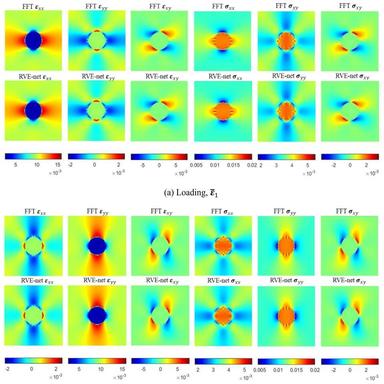
Errors of the strain predicted by RVE-net for the three loading conditions.